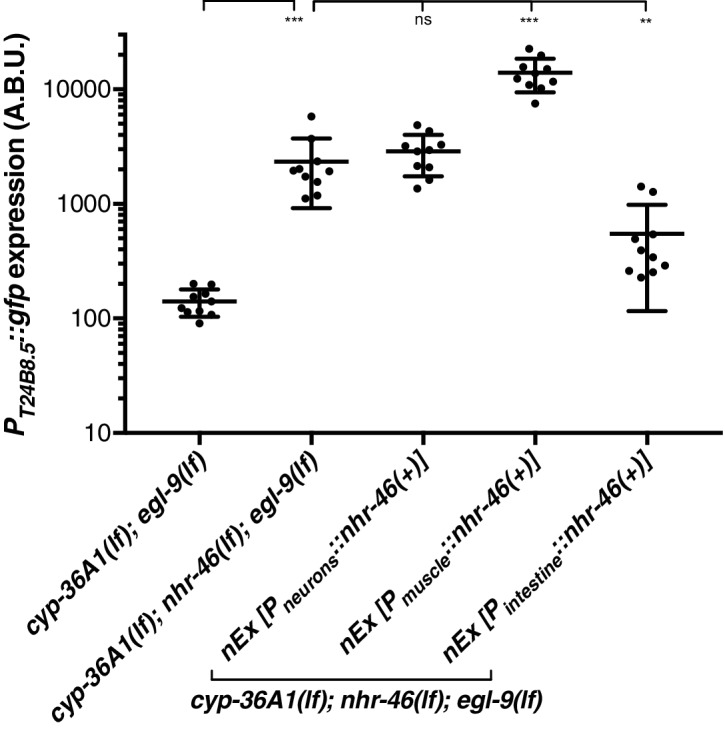
Replicate data for PT24B8.5::gfp reporter expression.Replicate data for Figure 5B. Quantification of n = 10 animals. **p<0.01, ***p<0.001 considered significant. ns (p>0.05), not significant (Student’s t-test with Holm-Bonferroni correction).